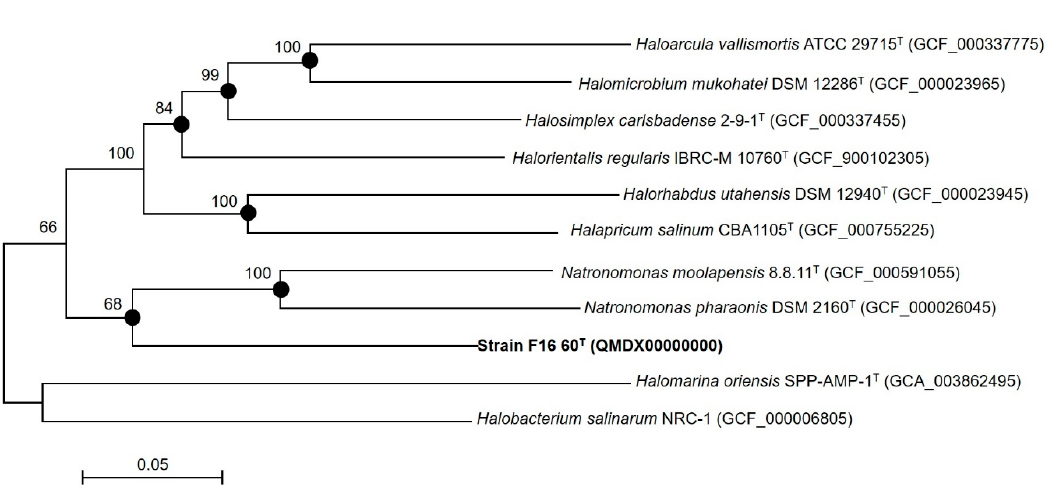
Figure 3. Maximum-likelihood core gene phylogenetic tree including 11 genomes of members of the order Halobacteriales . This tree was based on the Jukes–Cantor distance calculated from the alignment of 170 shared orthologous single-copy genes of these genomes. Filled circles indicate branches that were also supported by the neighbour-joining algorithm. Bootstrap values higher than 60% are indicated at branch-points. Bar: 0.05 substitutions per nucleotide position.